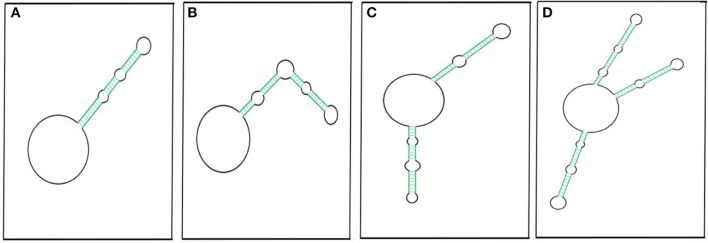
Pictorial representation of circRNAs with putative secondary imperfect duplex(es). CircRNA with a double-stranded RNA (dsRNA) foldback structure can be made possible by having single (A,B), double (C), or multiple projections (D). Colored parallel lines represent different sizes of complementary regions (dsRNA regions), and black loops represent different sizes of non-complementary regions. The pictorial representation is not to scale.